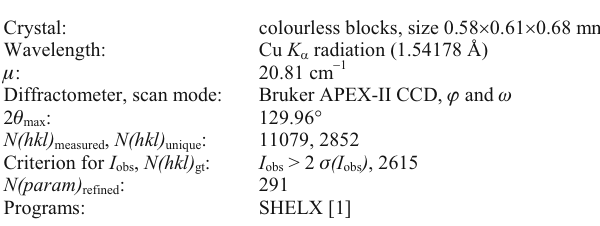
Table 1. Data collection and handling.